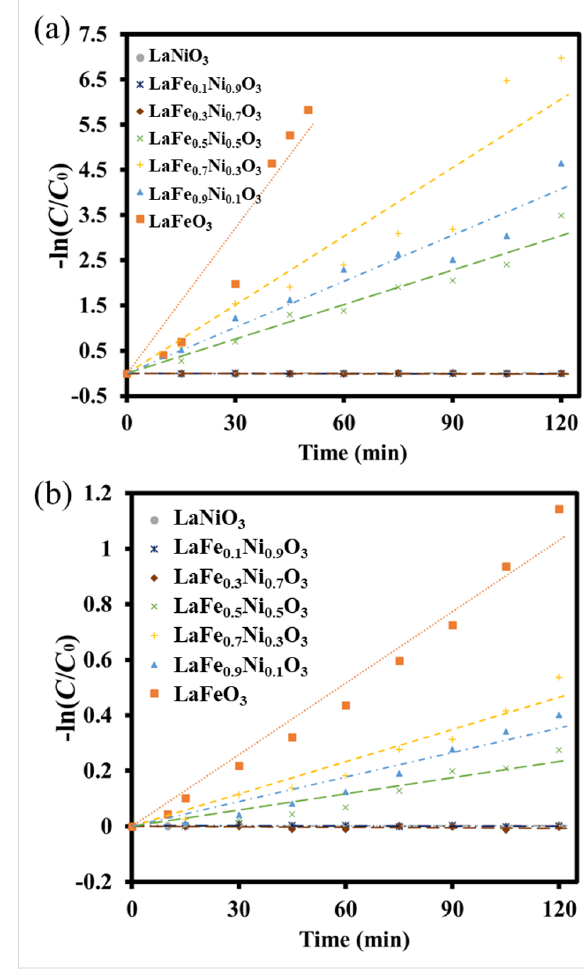
Figure 9: Kinetic analysis of MB degradation experiments using various LaFe x Ni 1 − x O 3 with different Fe/Ni ratios at (a) pH 0 and (b) pH 7. ducted for the samples prepared at pH 0 in Table 1. However, the R 2 values were too low to represent their kinetic model. Therefore, 1st order reaction kinetics was more suitable for describing the kinetic model of LaFe x Ni 1 − x O 3